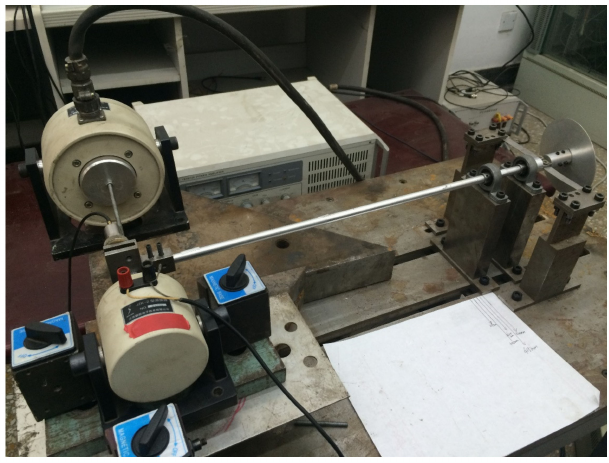
Figure 11. The active control test of the cantilever beam